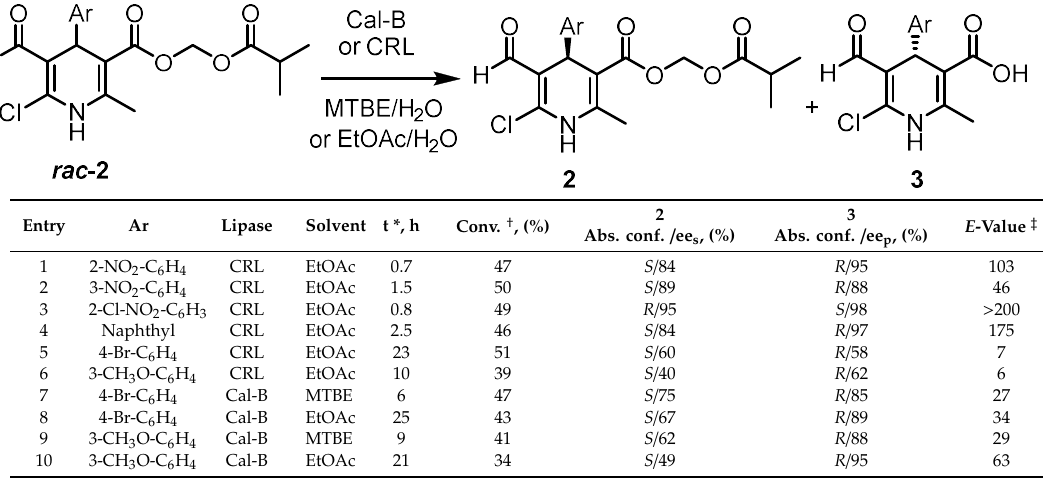
Table 2. Lipase-catalysed kinetic resolution of racemic [(2-methylpropanoyl)oxy]methyl ester